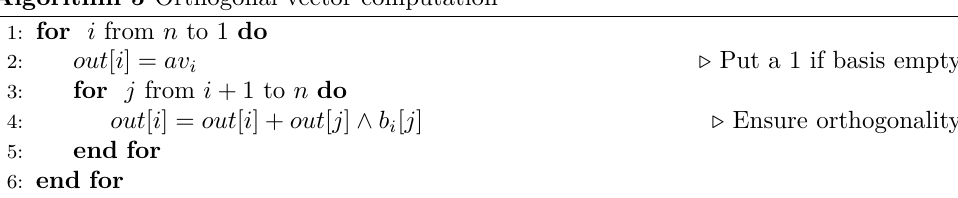
Algorithm 5 Orthogonal vector